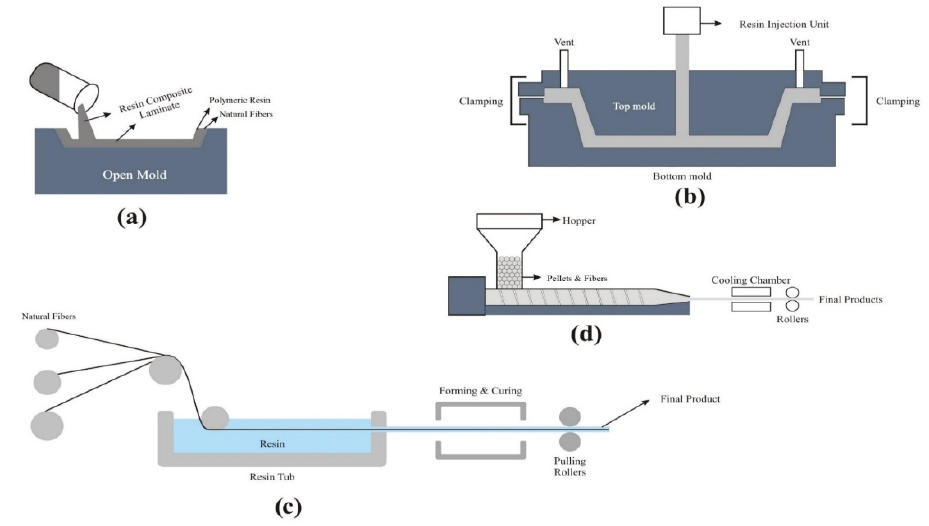
Figure 5. Different fabrication methods ( a ) Hand layup ( b ) Resin transfer molding ( c ) Pultrusion ( d ) Extrusion.